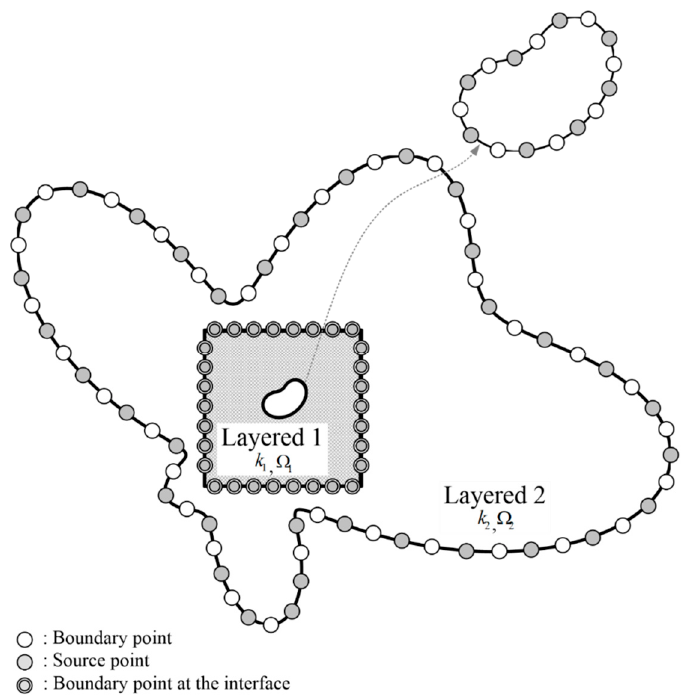
Figure 20. Illustration of the collocation of boundary and source points.